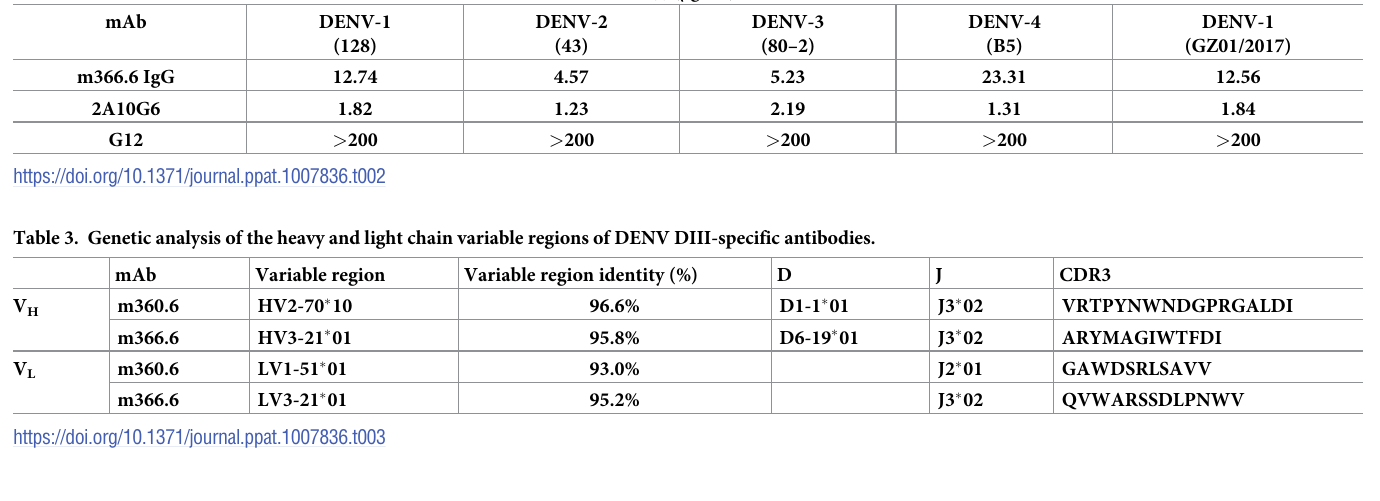
V λ gene was from IGLV1-51. In contrast, the m366.6 VH gene was derived from the IGHV3- 21 and the V λ gene was from IGLV3-21. Interestingly, we found that the encoding genes of both m360.6 and m366.6 closely resembled their corresponding germline gene segments. Notably, m366.6 VH and V λ gene shared 95.8% and 95.2% sequence identities with the IGHV3-21 � 01 and IGLV3-21 � 01 germlines respectively (Fig 4A and 4B). These results indi- cated that the mAb m366.6 is a germline-like antibody, which, in general, could show better drug properties and lower immunogenicity compared to somatically hypermutated antibodies [59].